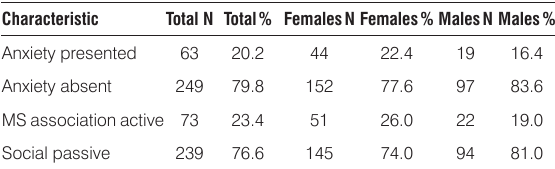
Table 3. Prevalence of anxiety and social activity by gender.